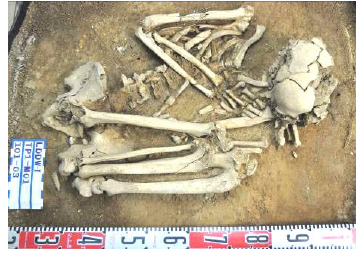
Figuer 4. The condition of burial after cleaning.